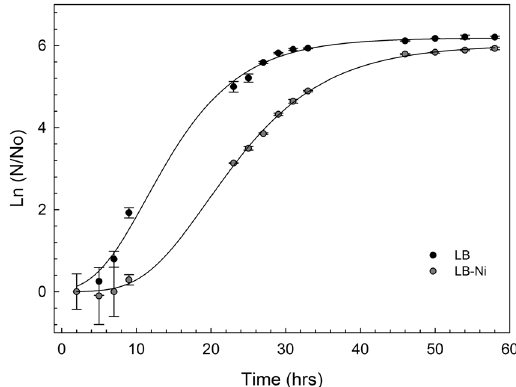
Figure 1. Growth curves of Sphingobium sp. ba1 cells. Cell cultures were grown at 30 °C for 60 hours in LB broth and kanamycin, with or without 10 mM NiCl 2 (both cultures were in triplicate). Optical density of cultures of Sphingobium . sp. ba1 in LB and LB-Ni media are shown as a function of growth